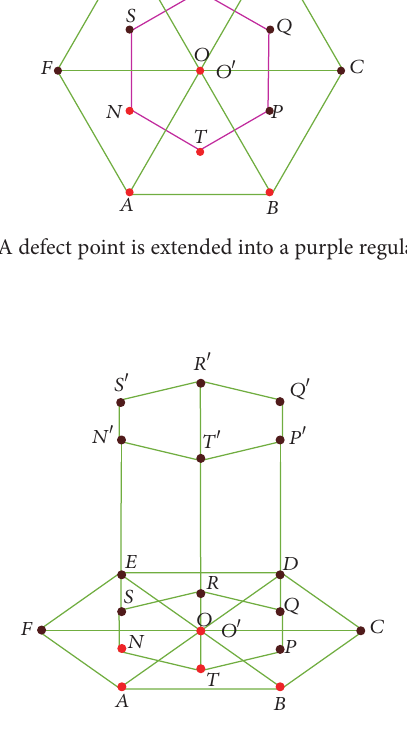
Figure 7: The regular hexagonal prism model for volume calcula- tion.